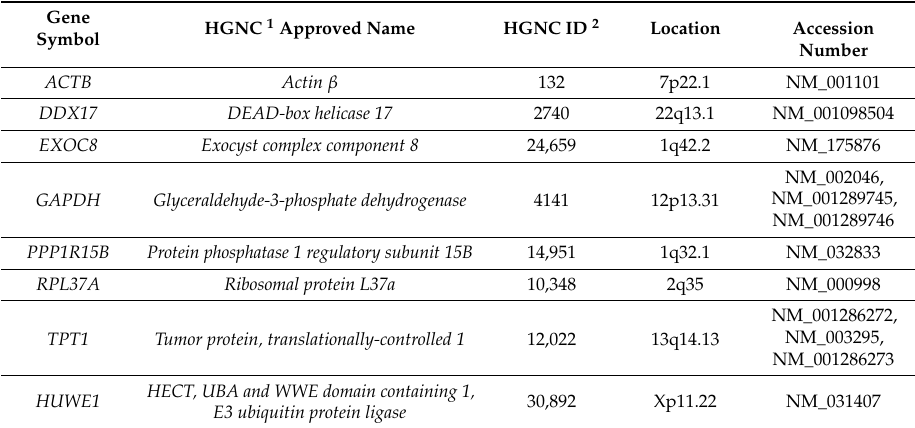
Table 1. Gene symbols and names mentioned in this